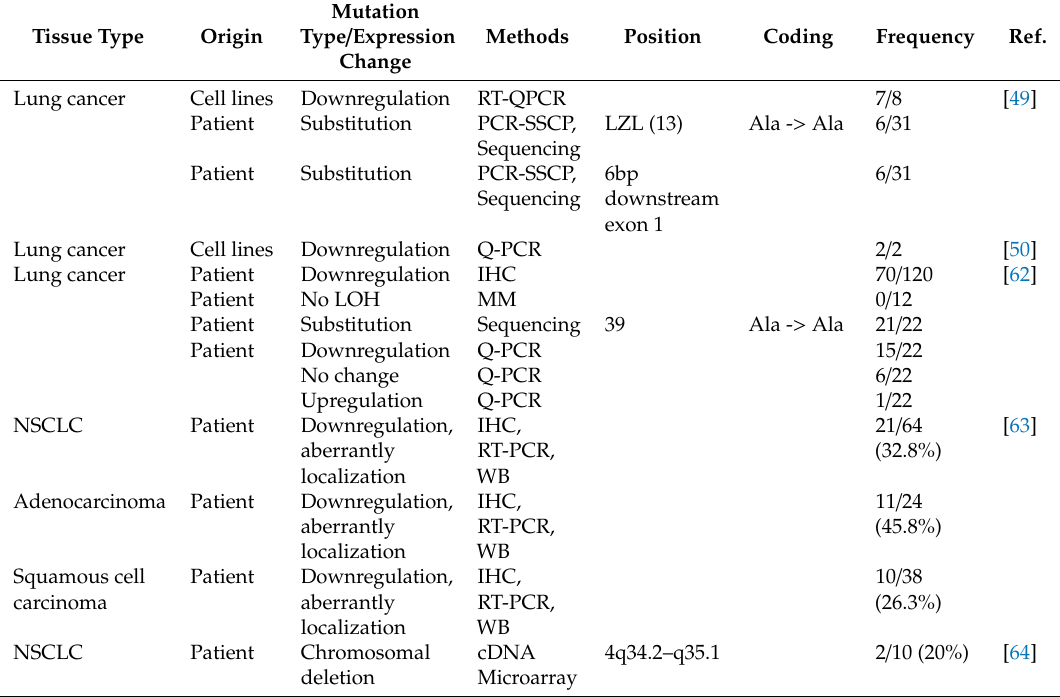
Table 1. ING2a status in human lung